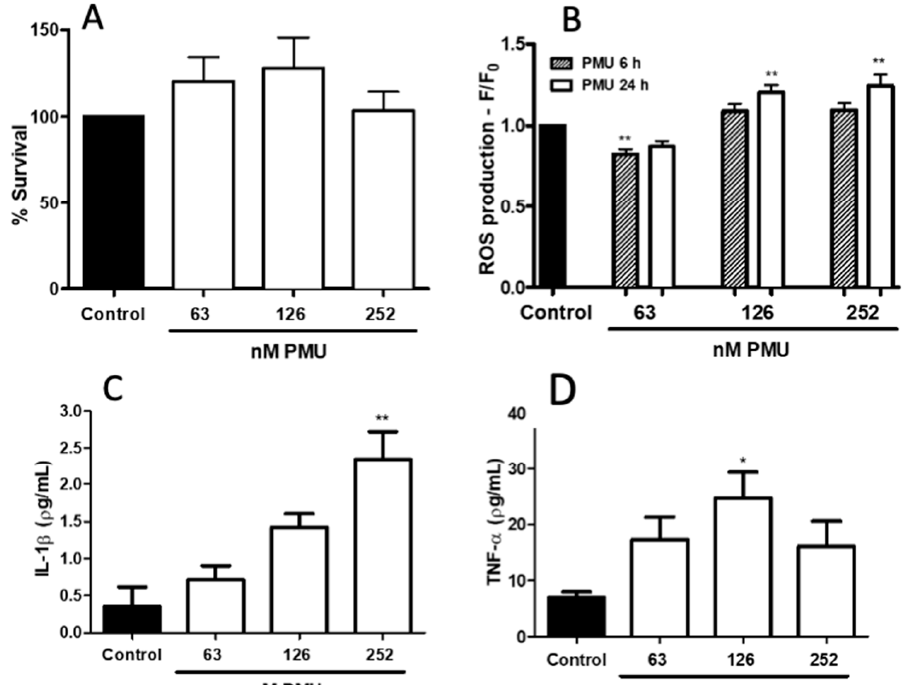
Figure 3. Effects of Proteus mirabilis urease on HEK293 cells. Cultured human kidney embryonic (HEK293) cells were incubated with NaPB 7.0 (control), or PMU at 63, 126 and 252 nM for 6 h and 24 h. In panel ( A ), cell culture viability was analyzed by the MTT test 24 h after exposure to a buffer or PMU. After the treatments, cultures’ supernatants were removed and cells were treated with MTT (5 mg/mL) for 4 h at 37 °C, then suspended in 100 µL DMSO. Absorbances were read at 570 nm. Mean ± SEM (N= 4–5 for the control and 5–8 for treatments). * p < 0.05, ** p < 0.01 vs. control. In panel ( B ), intracellular production of reactive oxygen species was assessed by pre-incubating the cells with CM-DFFDA (2 mM, 30 min) before exposure to a buffer or PMU, followed by fluorescence analysis (excitation 495 nm, emission 527 nm). Mean ± SEM (n = 10, controls; n = 8–10 for treatments) * p < 0.05, ** p < 0.01, vs. control. In panels ( C ) and ( D ), HEK293 cells were incubated for 6 h with the NaPB 7.0 (control), 63, 126, 252 nM PMU. Afterwards the cultures’ supernatants were collected for detection of IL-1 β (panel A) and TNF- α (panel B) by ELISA. The data were analyzed by one-way parametric ANOVA with a Dunnett post-test, the results are mean ± SEM (n = 4–5, control, and 4–7 for each PMU dose). * p < 0.05, ** p < 0.01 vs. control.